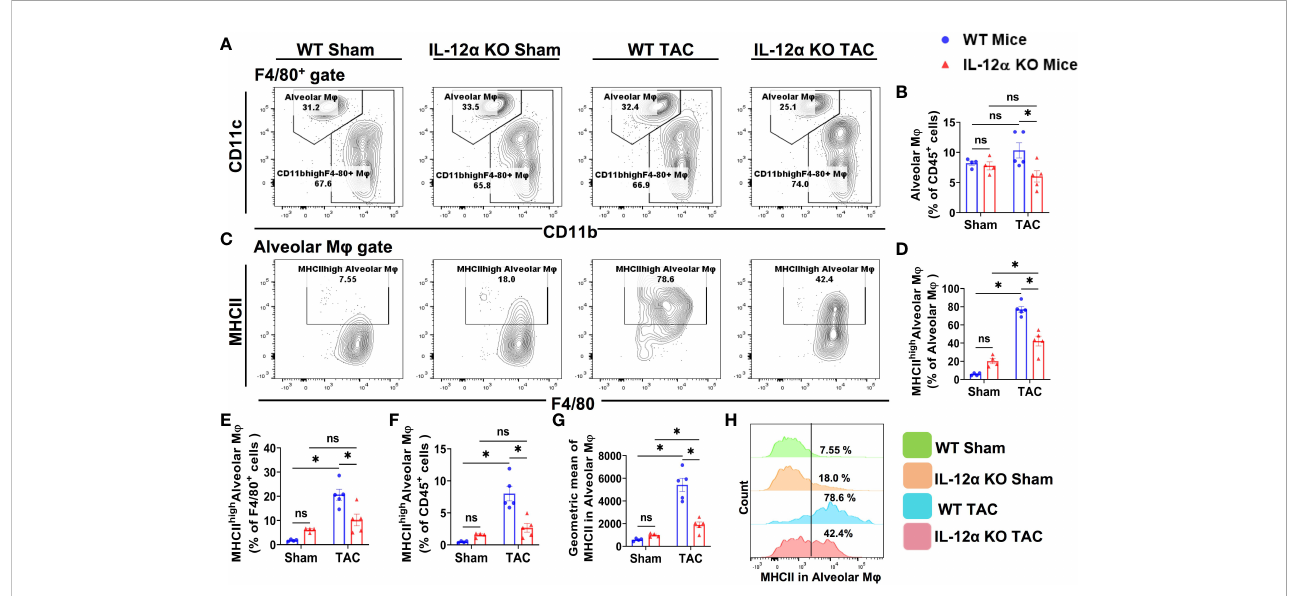
FIGURE 6 IL-12 a KO signi fi cantly ameliorated TAC-induced accumulation of lung alveolar macrophages (CD11c high CD11b low F4/80 + ) and their activation. (A) Flow cytometry plots for alveolar macrophages. (B) Quanti fi ed alveolar macrophages within CD45 + leukocytes. (C) Flow cytometry plots for the detection of MHCII expression in alveolar macrophages. (D – F) Quanti fi ed percentages MHCII high alveolar macrophages within alveolar macrophages, F4/80 + cells, and CD45 + cells, respectively. (G) Mean fl uorescent intensity of MHCII in alveolar macrophages. (H) Representative histograms showing the relative MHCII expression in each group. *p<0.05, ns, non-signi fi